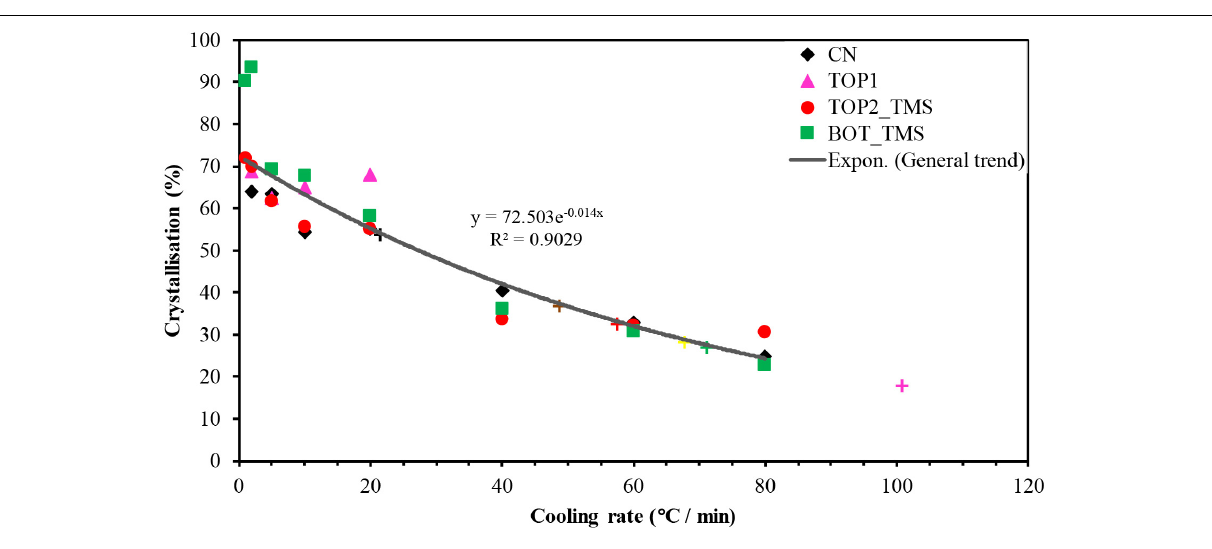
cooling rates (e.g. ∼ 63 to ∼ 90% crystallization at 1–2 ◦ C min − 1